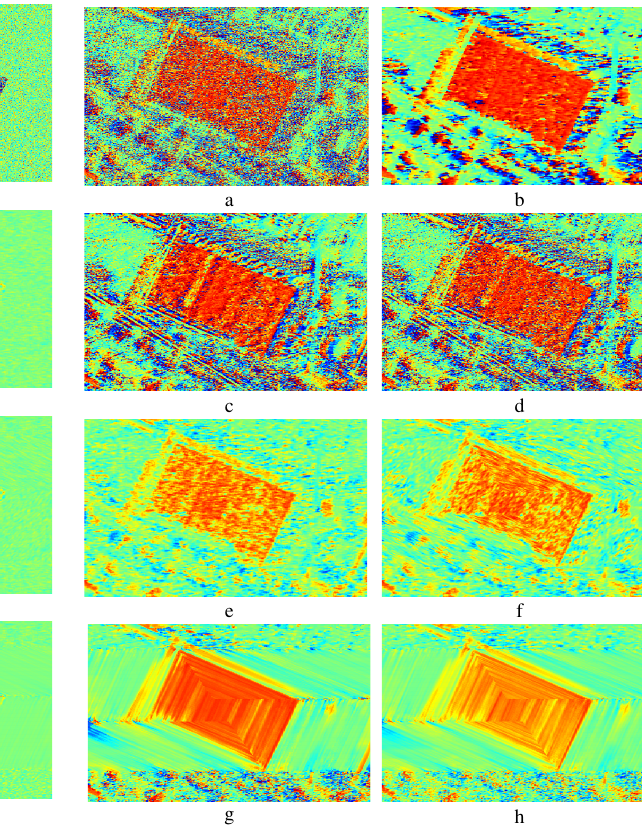
Figure 4. Filtering of simulated interferometric phases: a) original simulation, b) noisy simulation, c) median-filter, d) mean-coherence-filter, e) adapted Lee-filter, using GIS information for f) fixed-window-filter (mean-coherence), g) adaptive-window-filter (median), and h) adaptive-window- filter